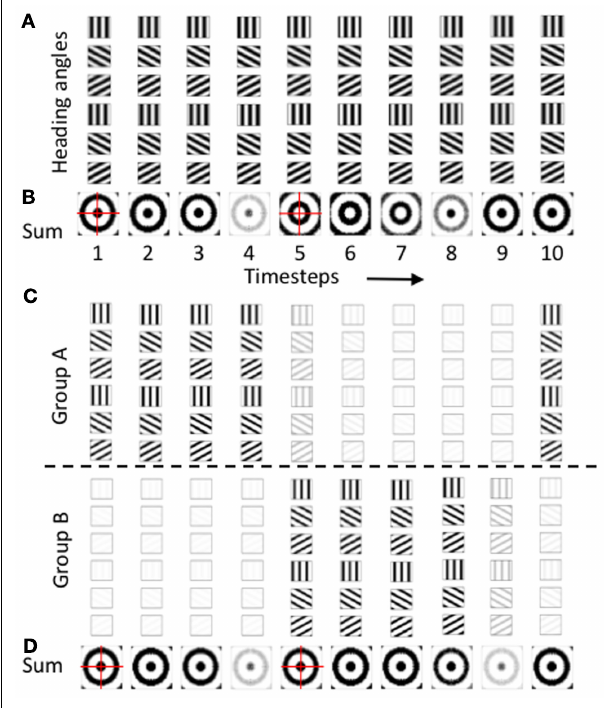
FIGURE 6 |Temporal dynamics of heading angle cells and synaptic input to grid cells. (A) The synaptic output of heading angle cells coding one spatial phase ( px = 15, py = 15) are shown for each of 10 time steps, with each column showing the same 6 headings (18 out of 24 headings are not shown). Note that due to the different temporal phases, the pattern of activity shifts in the direction of the heading angle on each time step. (B) Sum of synaptic input results in a standing wave of oscillations with a circularly symmetric pattern. On timesteps 1–4, the pattern has maximal activity in the center (spatial phase px = 15, py = 15) and has one ring outside the center. On timesteps 5–7, the sum of heading angle outputs results in the opposite pattern. (C) Use of two separate populations of heading angle cells overcomes this problem. On timesteps 1–4, Group (A) shows output activity with a maximum in the center ( px = 15, py = 15). On timesteps 5–9, Group (A) is decreased and group (B) is increased in activity to give a similar synaptic input to the grid cell population. (D) With two groups, the synaptic input from the heading angle cells is similar in pattern at most